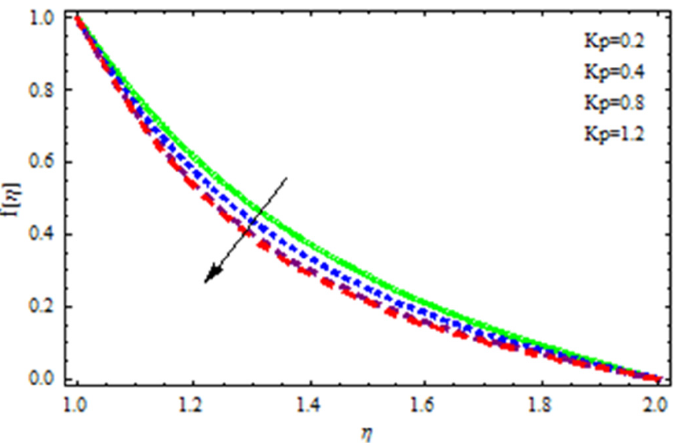
Figure 7. Influence of Kp on the velocity curve in the case of the Reynolds model.